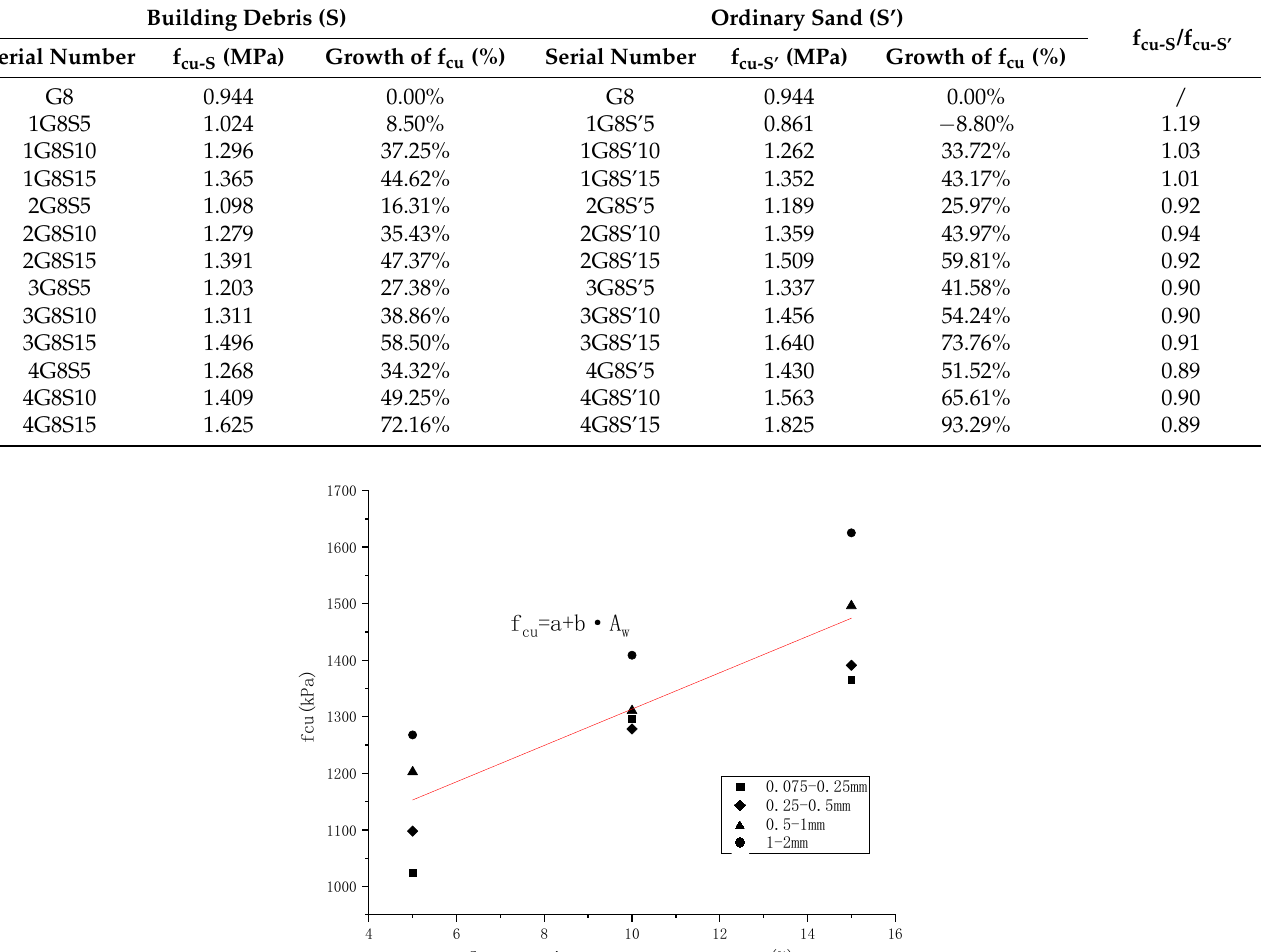
Table 2. Compressive strength between building debris (S) and ordinary sand (S’) solidified soil.